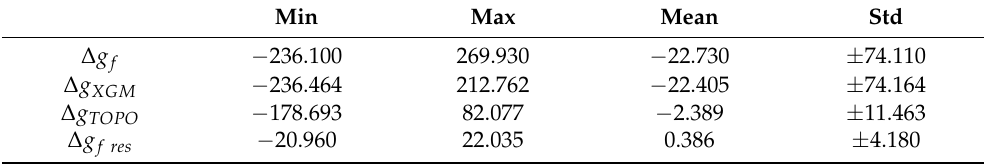
Table 6. Statistics of the local free-air gravity anomaly field and their residuals. Units: (mGal). Min Max Mean Std ∆ g − 236.100 269.930 − 22.730 ± 74.110 f ∆ g − 236.464 212.762 − 22.405 ± 74.164 XGM ∆ g − 178.693 82.077 − 2.389 ± 11.463 TOPO ∆ g − 20.960 22.035 0.386 ± f res